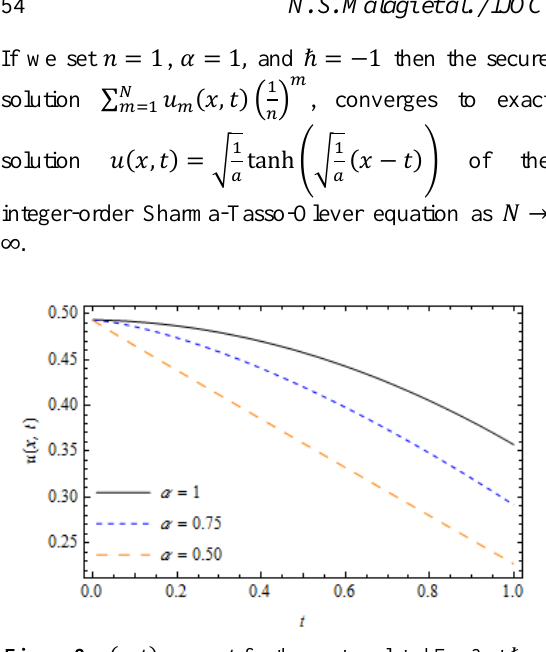
Figure 8. 𝑢(𝑥, 𝑡) versus 𝑡 for the contemplated Ex. 3 at ℏ = −1.858,𝑥 = 5, 𝑎 = 4, and 𝑛 = 1 for distinct of 𝛼 .